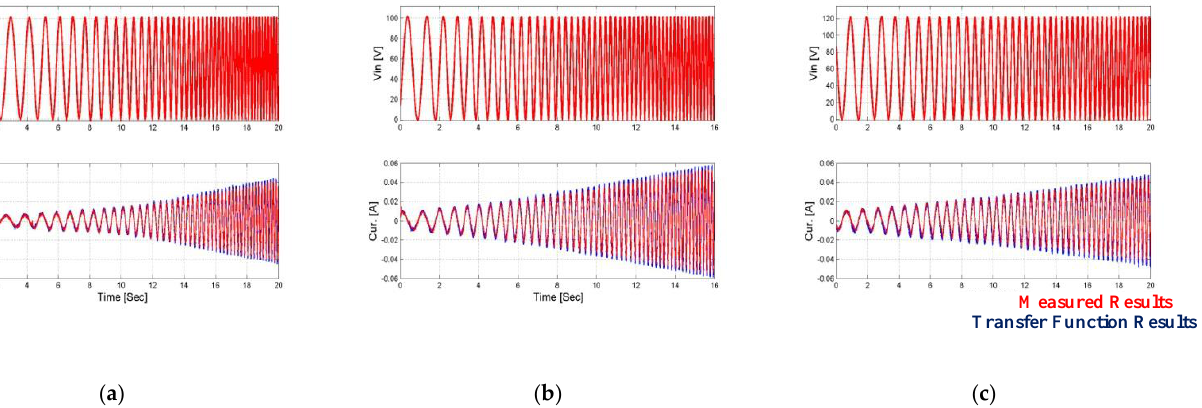
Figure 17. Comparison of uniform transfer function vs. measured output current results when the second load is applied. ( a ) Vin = 80 V, ( b ) Vin = 100 V, and ( c ) Vin = 120 V.